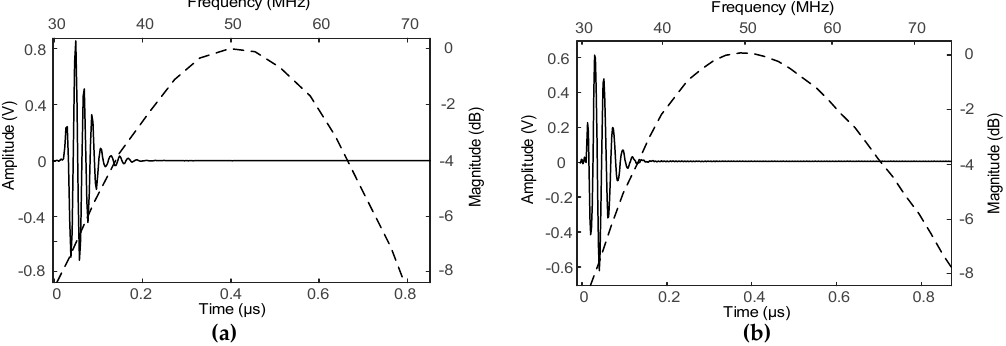
Figure 1. The simulated pulse-echo response (solid line) and their frequency spectra (dashed line) for 50 MHz PVDF of ( a ) single-focal point transducer and ( b ) the second part of multifocal point transducer. The simulated pulse-echo response and frequency spectra of the first part were similar to the signals of single-focal point transducer, whereas the other parts were similar to the second part. From these Equations (1)–(4), for the SFP transducer at the center frequency of 50 MHz, the focal length of 12.7 mm, the aperture diameter of 9 mm, and propagation speed of water is 1540 m/s, the focal zone was calculated as 0.48 mm, and the lateral resolution was 44 μm . To effectively extend this focal zone, the authors designed the MFP transducers that have multiple focal zones. These focal zones were slightly overlapped with each other to generate continuous focus depths.